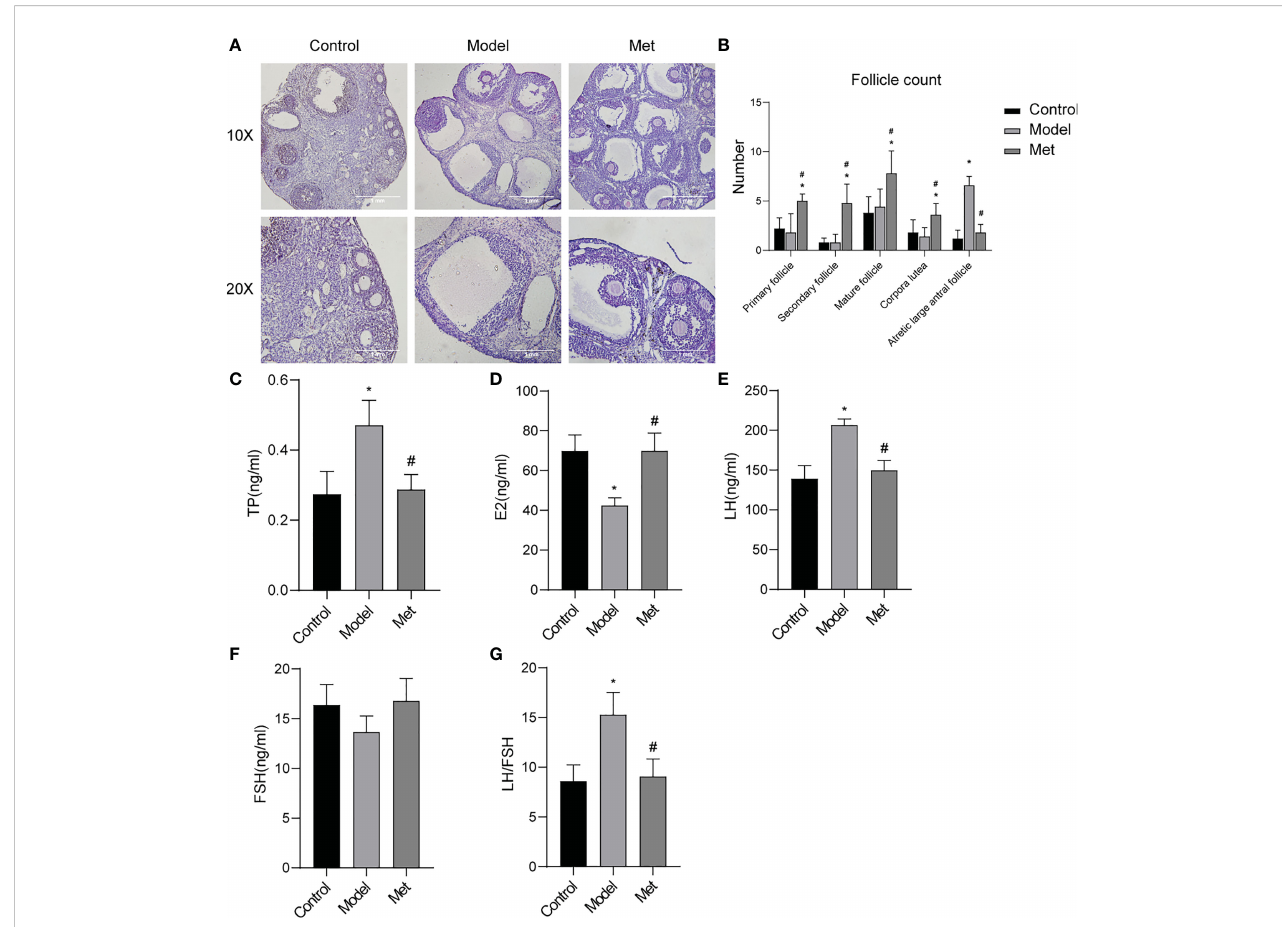
FIGURE 3 Metformin improved the ovarian morphology and function of PCOS mice. (A) H & E staining of mouse ovary; (B) Mouse ovarian follicle count; (C) Serum testosterone (TP) level in mice; (D) Serum estrogen (E2) level in mice; (E) Serum luteinizing hormone (LH) level in mice; (F) Serum follicle stimulating hormone (FSH) level in mice; (G) LH/FSH. Mean ± SEM, n = 6. *P < 0.05 vs control group; #P < 0.05 vs PCOS